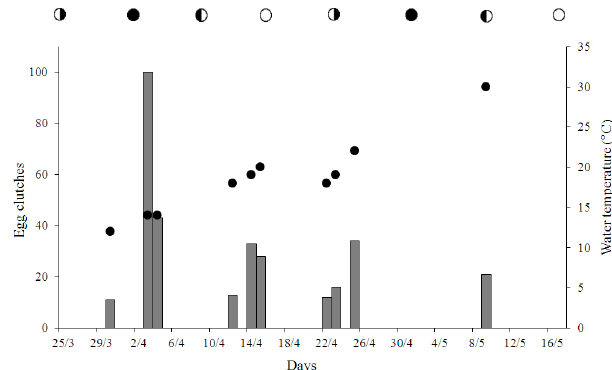
Figure 1. Number of oviposited clutches by Hyla intermedia (bars) and water temperature (black circles) at the study site in 2003. Moon phases are also